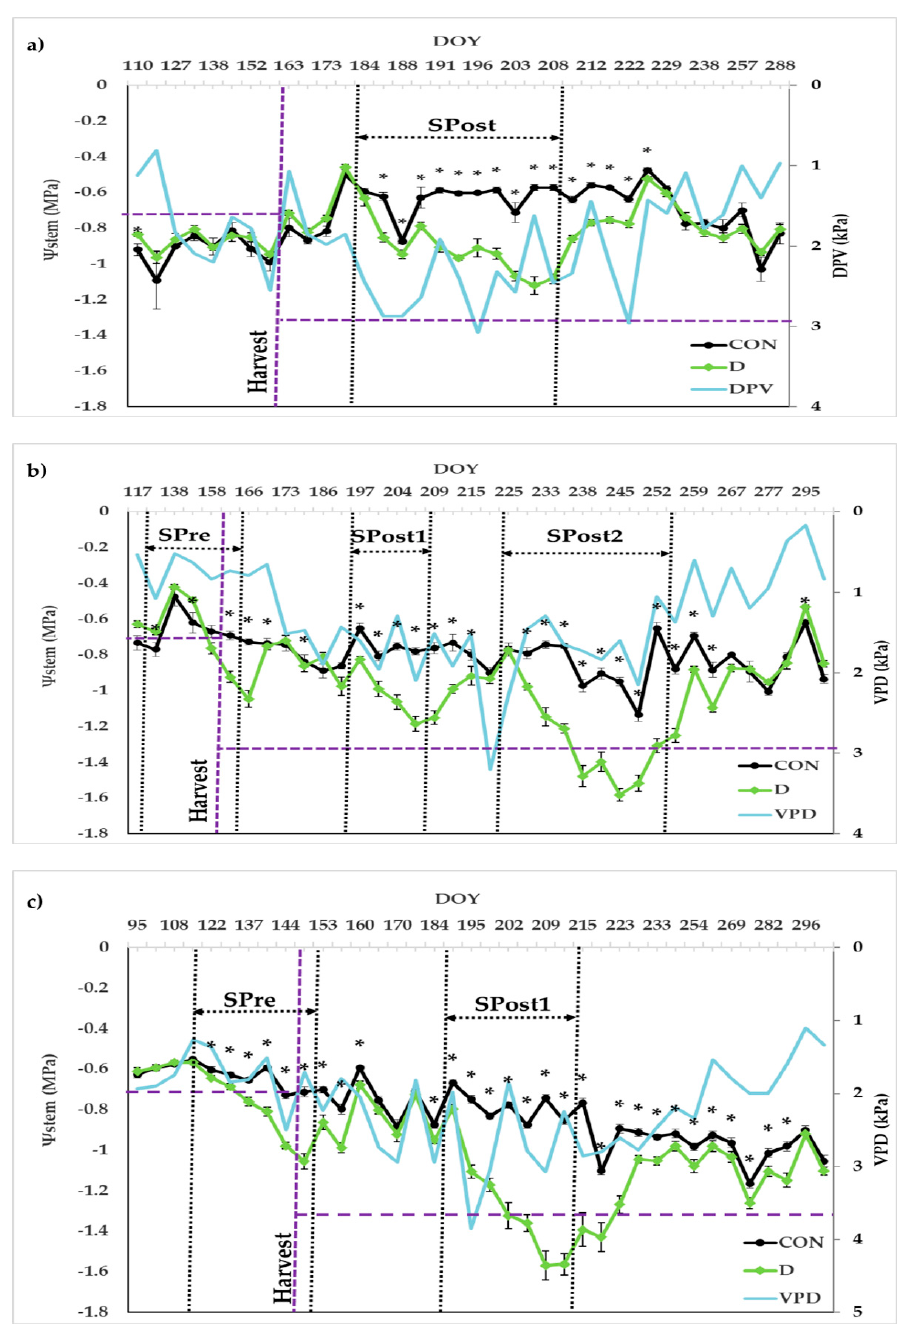
Figure 2. Seasonal patterns of vapor pressure deficit (VPD) and midday stem water potential ( Ψ stem) corresponding to the control (CON) and drying (D) treatments in “Red Beaut” plum trees during 2015 ( a ), 2016 ( b ), and 2017 ( c ). Each value is the mean of 32 measurements ± standard error. An asterisk (*) indicates statistically significant differences between treatments at p < 0.05. The vertical black dashed line indicates the start and end of the drying period. DOY is day of the year. The vertical violet dashed line indicates when harvest took place. The horizontal violet dashed line indicates the threshold established for each crop phase recommended by Samperio et al. [24]. Pre is the period from fruit set to harvest of the current year. Post is the period from harvest to the onset of leaf fall of the current year.